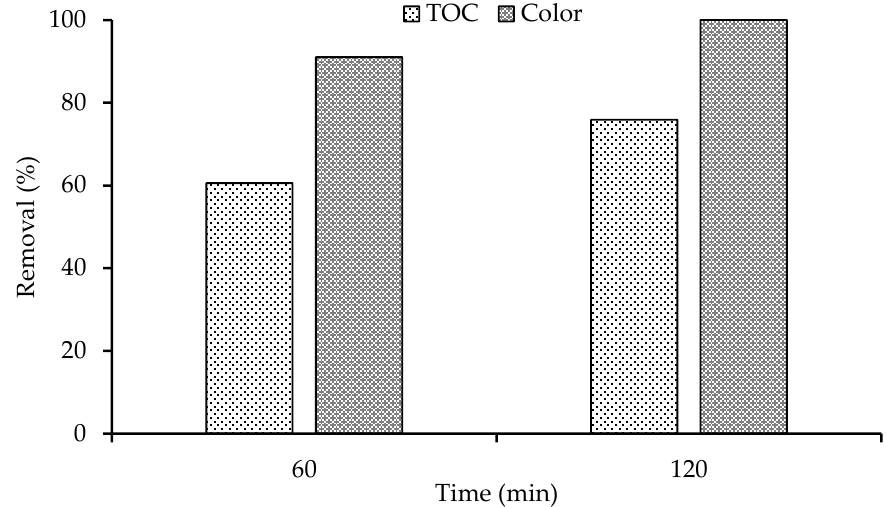
Figure 13. Comparison between decolorization and TOC removal of RB5 using 0.1Fe-TiO 2 -300.